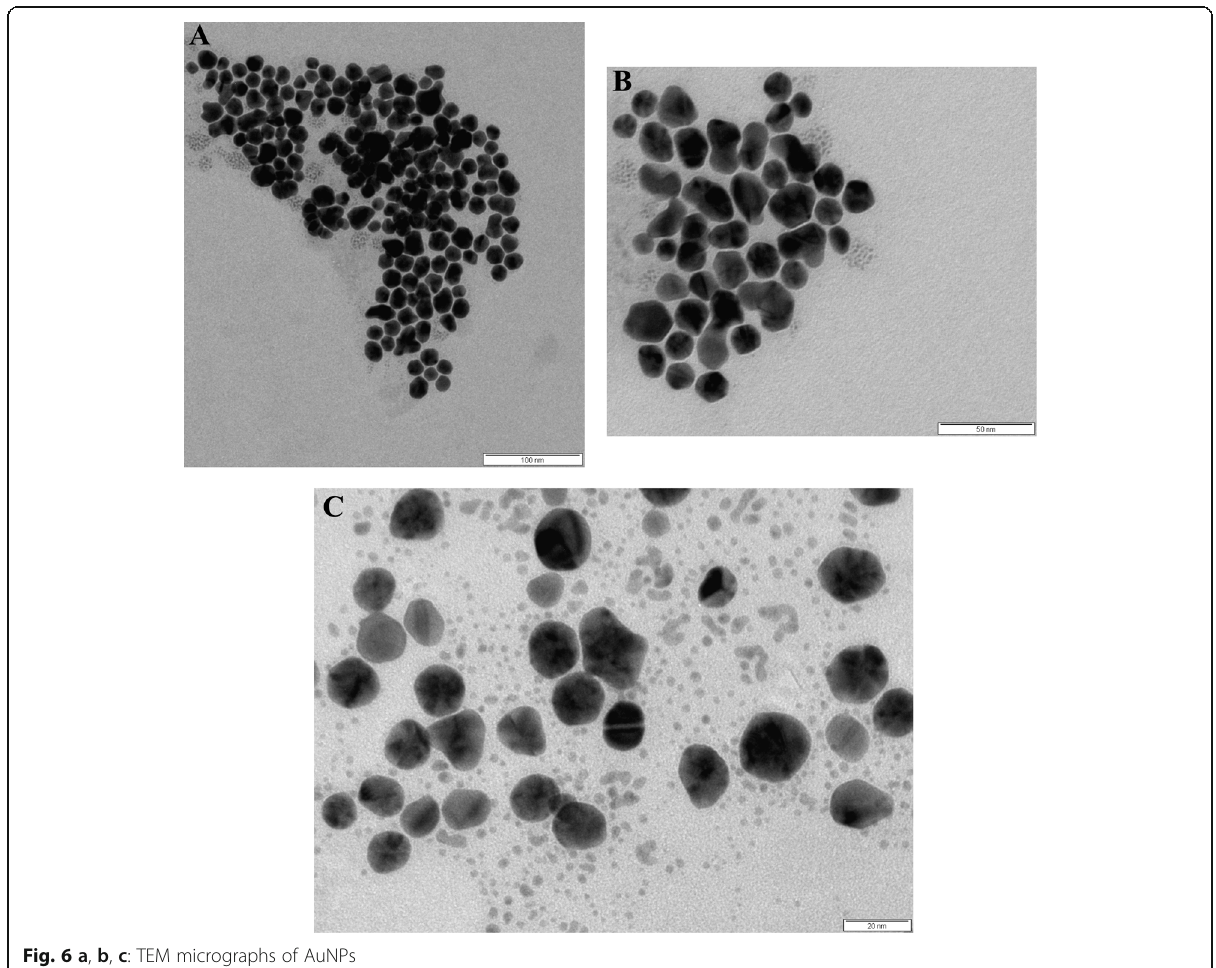
Fig. 6 a , b , c : TEM micrographs of AuNPs